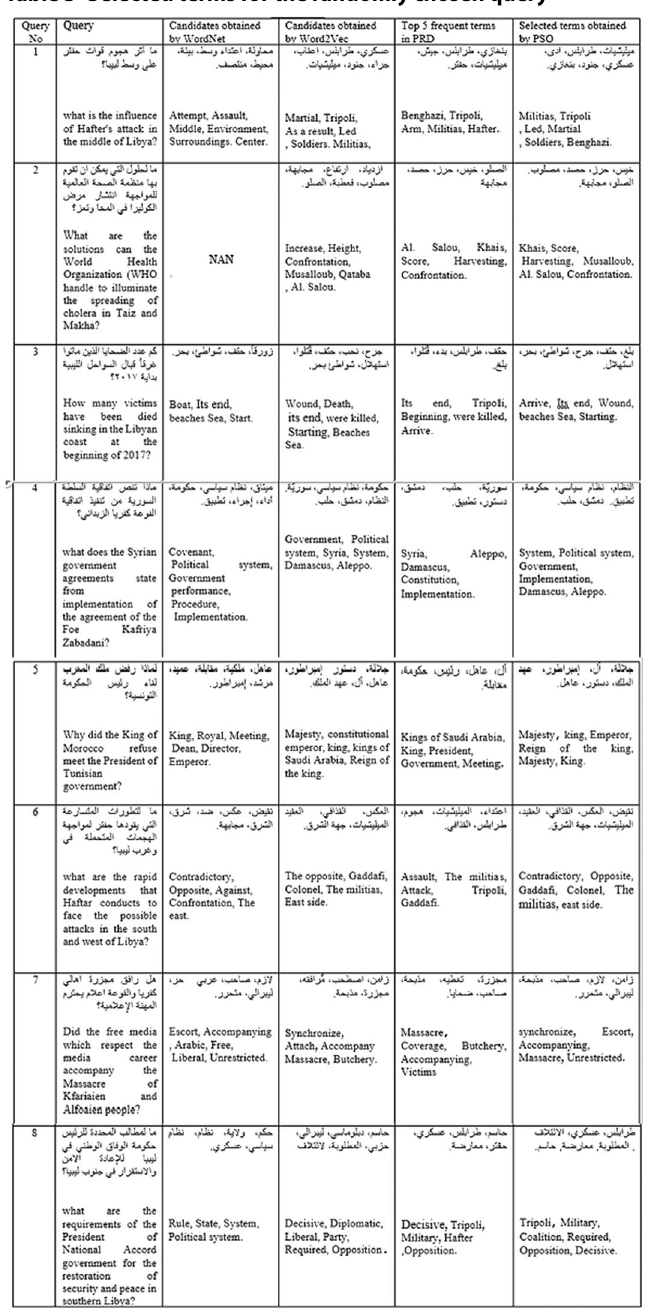
Table 3 Selected terms for the randomly chosen